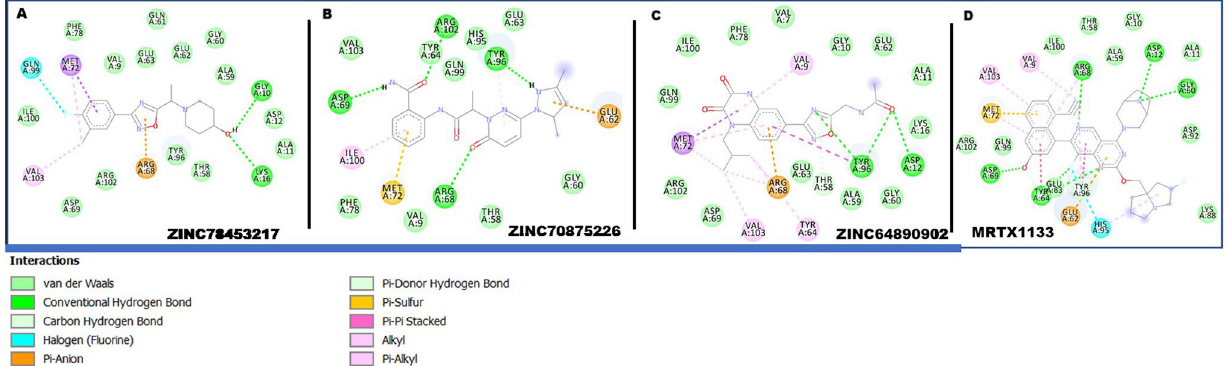
Figure 7. 2D molecular interactions of MRTX1133 and selected compounds within the binding site of KRAS allosteric binding site. The selected compounds and MRTX1133 show similar interactions with the binding site residues suggesting the selected compounds have the potential to elicit similar therapeutic